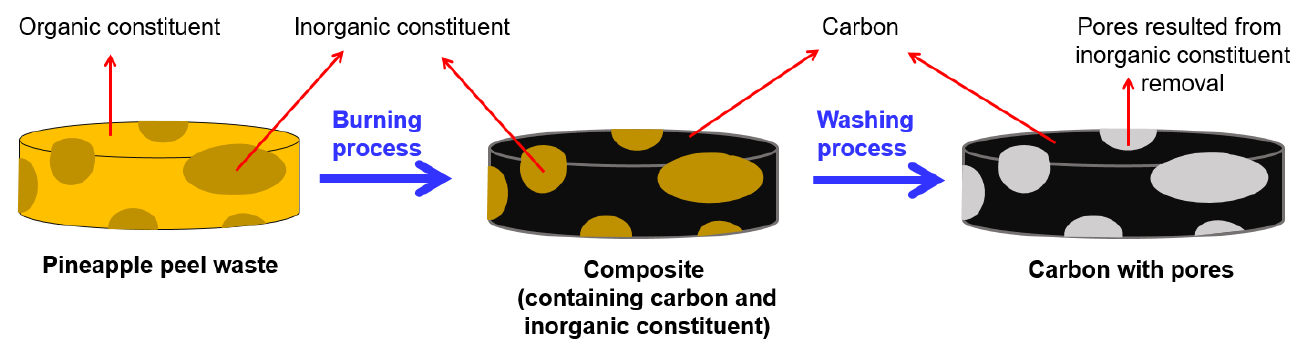
Fig. 7. Illustration of the pore formation in carbon